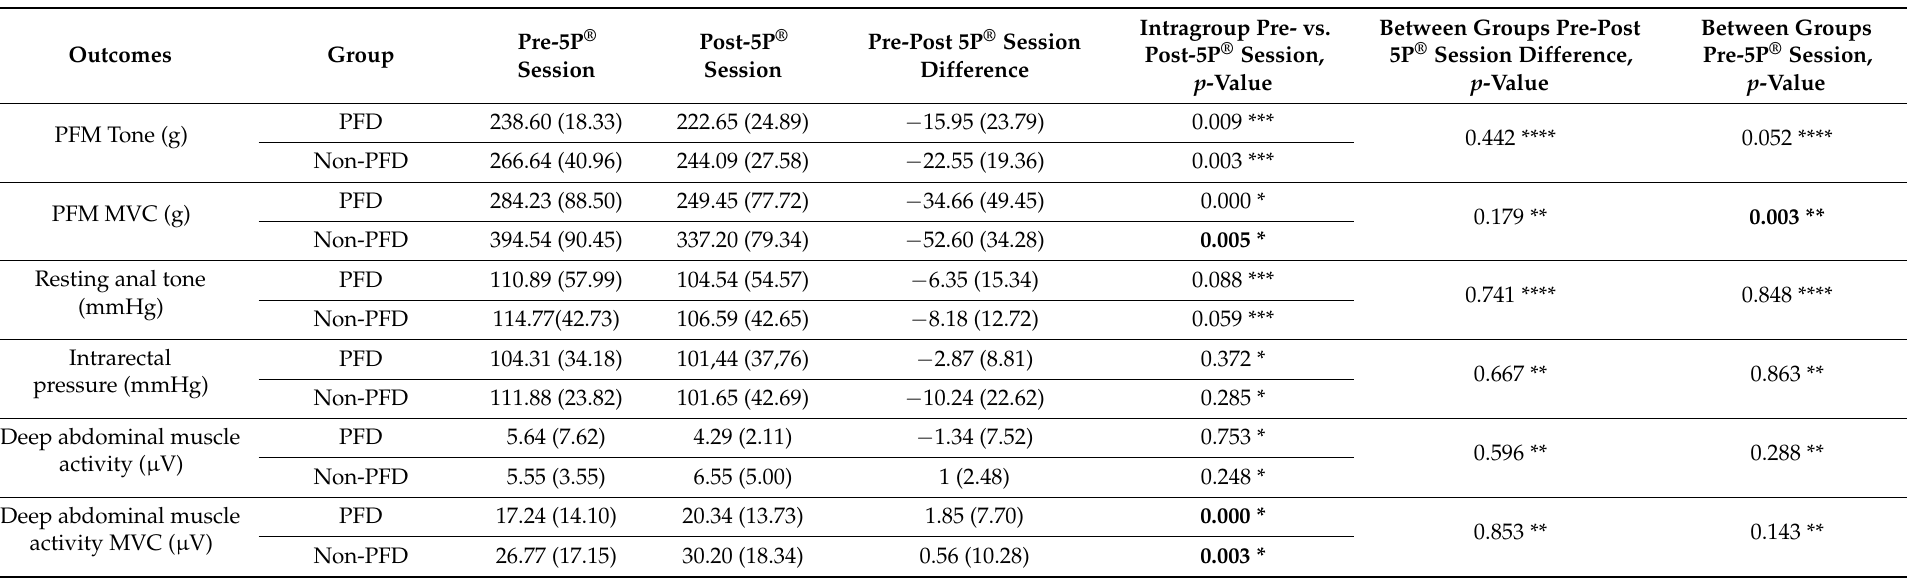
Table 2. Average change for each outcome between pre- and post-single 5P ®